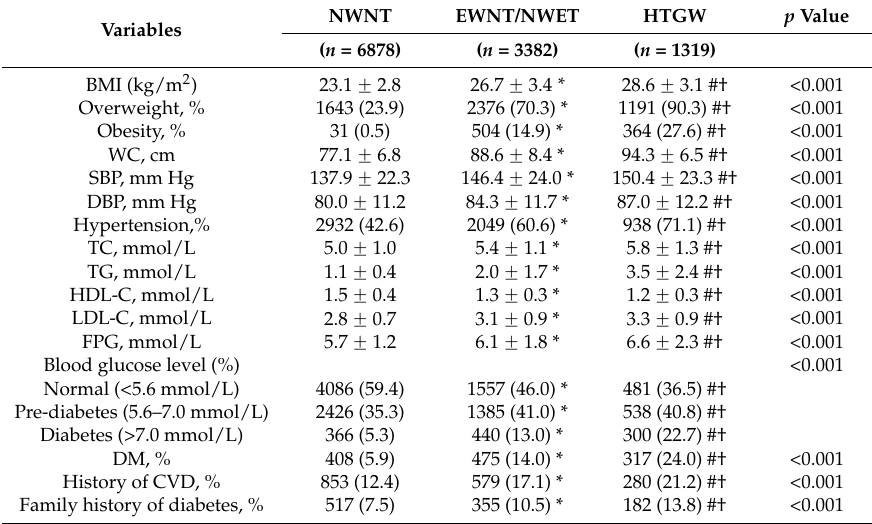
Table 2. Baseline clinical characteristics and laboratory data of the participants in each phenotype group ( n = 11,579).